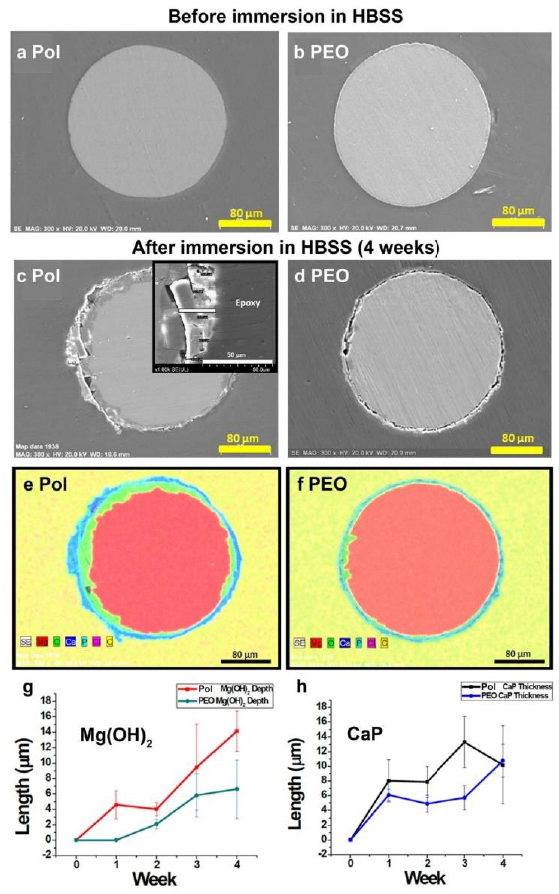
Figure 4. Effects of 4-week immersion in HBSS on Mg filaments through analysis of cross-sections. ( a - d ) SEM images of filaments before ( a , b ) and after ( c , d ) immersion. ( e , f ) EDX maps of filaments after immersion, merged element image. ( g ) Length (depth) of the Mg(OH) 2 layer measured in EDX images. ( h ) Length of the calcium phosphate (CaP) layer. With copyright permission from [35].